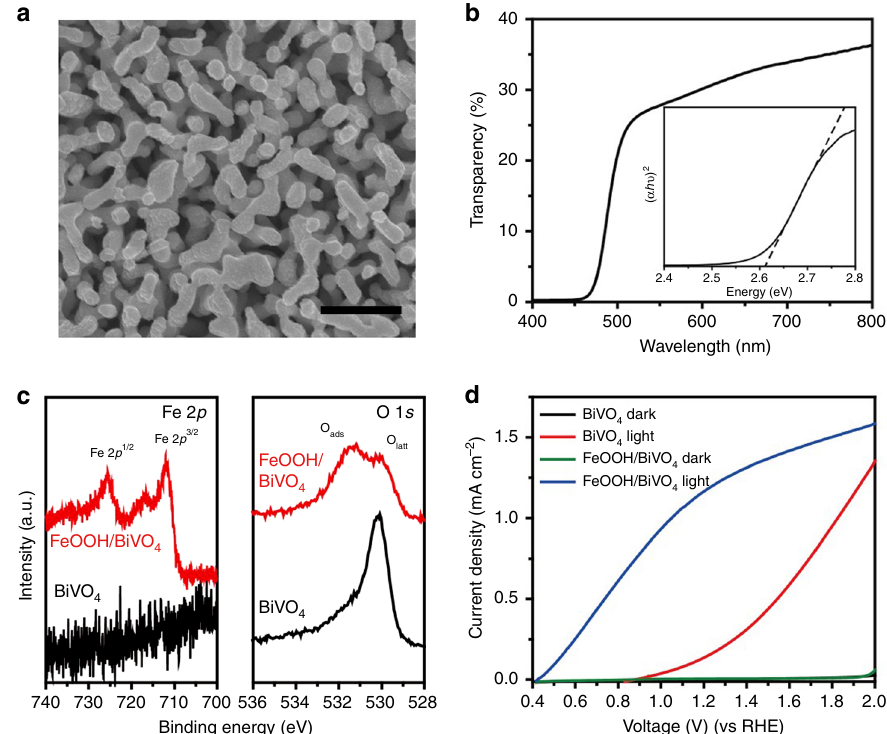
Fig. 2 Characterization of FeOOH/BiVO 4 photoanode. a SEM image of FeOOH/BiVO 4 (top view, scale bar: 500 nm). b Transparency of FeOOH/BiVO 4 measured by a UV-Vis spectrometer and a Tauc plot (inset) of BiVO 4 indicating 2.6 eV of bandgap. c XPS local scan spectra of Fe 2 p , O 1 s regions before (black) and after (red) the deposition of FeOOH on BiVO 4 . d PEC I – V characteristics of the BiVO 4 photoanode with (blue) and without (red) a FeOOH catalyst. The active area of the photoanode was 1 cm